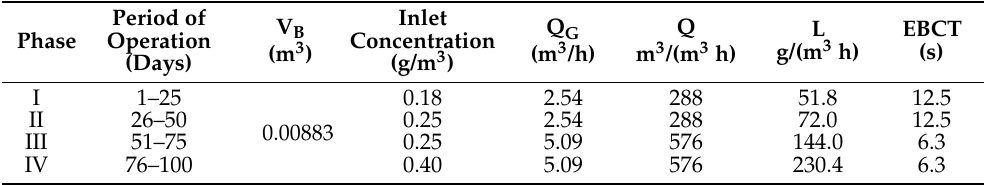
Table 1. Operation parameters of the biotrickling filter for continuous acetone